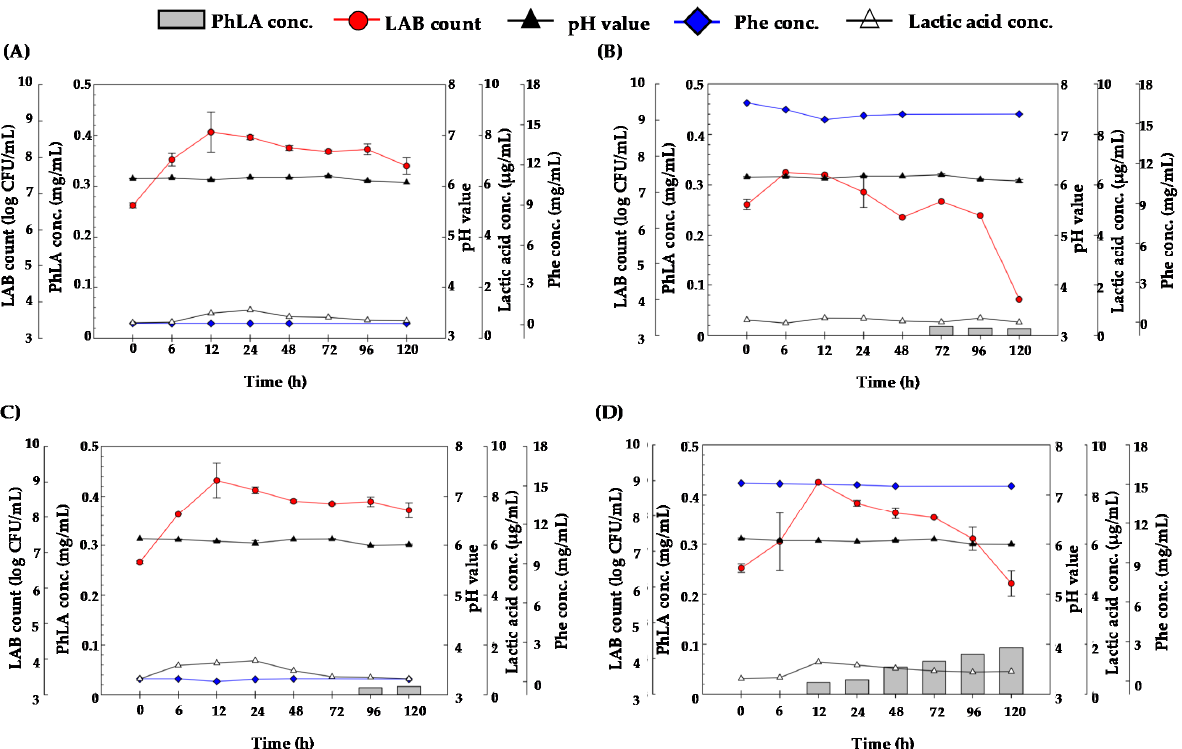
Figure 3. The LAB count, pH value, and concentrations of PhLA, lactic acid and phenylalanine (Phe) of ( A ) Porphyra residues (2%) with UF < 100 kDa (8.21%) and either ( B ) Phe (1.36%), ( C ) yeast extract (0.5%), or ( D ) both Phe (1.36%) and yeast extract (0.5%) and fermented with KP3 at 37°C for 0 to 120 h.